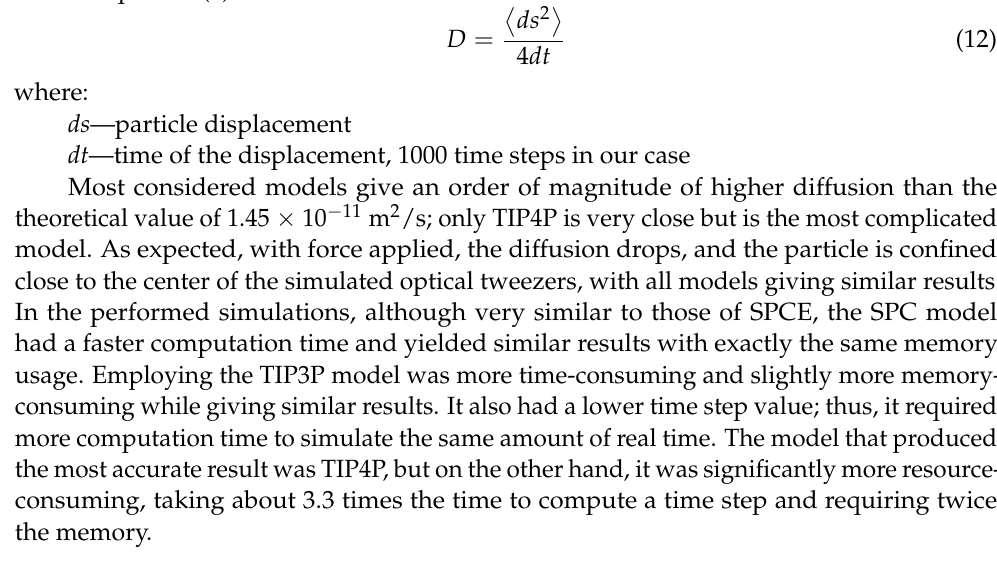
simulation with a 10 pN/nm trap stiffness ( c ); and TIP4P, with only a freely moving particle ( d